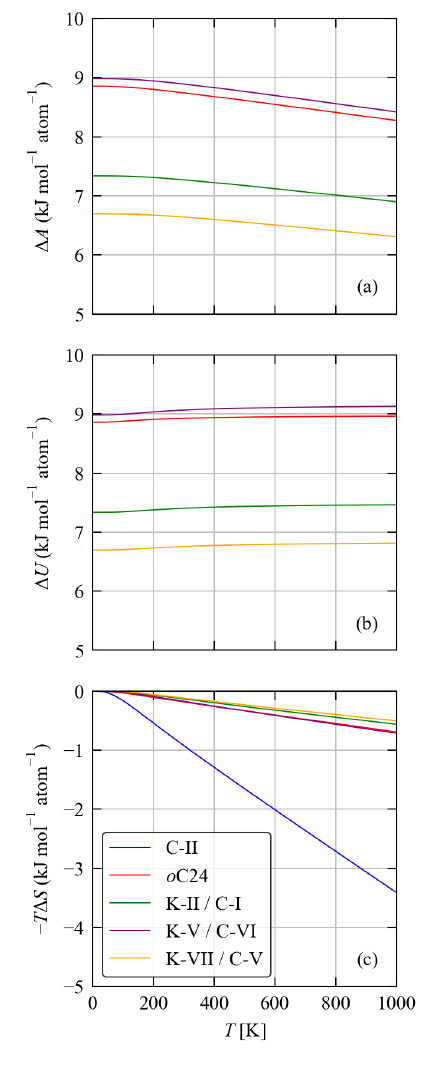
Figure 6. Breakdown of the Helmholtz free energy differences ∆ A ( a ), shown in Figure 5, into differ- ences in the internal energy ∆ U = ∆ U latt + ∆ U vib ( b ) and entropy − T ∆ S vib ( c